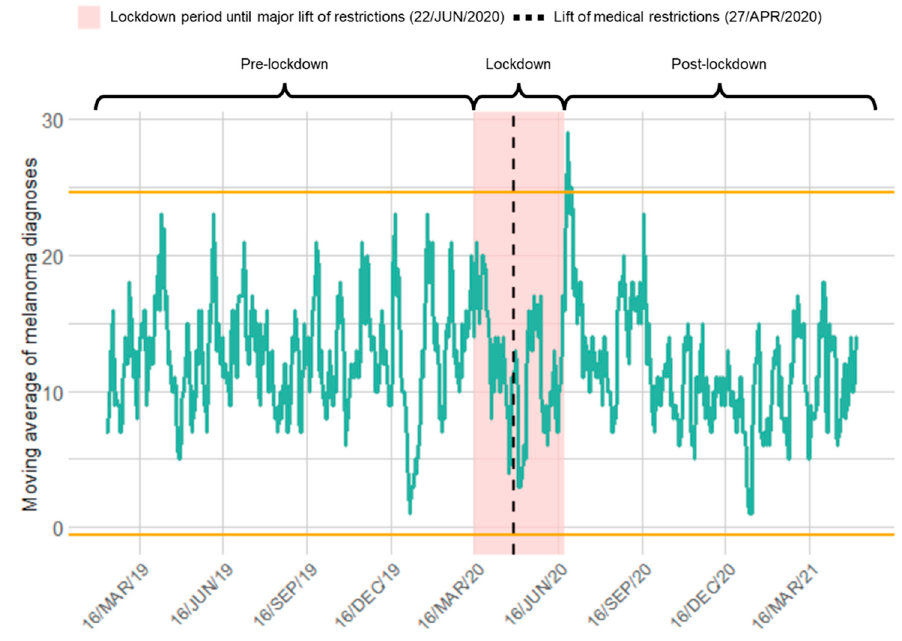
Figure 1. Time series of newly diagnosed melanomas relative to COVID-19 lockdown in Switzerland: A significantly higher rate of diagnosed melanomas was observed after the lift of major restrictions. The green line shows the rate, i.e., the moving 7-day average of diagnosed melanomas, considering a period of two years and three months centered on the official lockdown onset (16/MAR/20). The yellow lines represent three standard deviations above and below the mean of the considered interval. The shaded red area represents the lockdown period in Switzerland, defined here as the period between the official lockdown onset and the date for the major lift of restrictions (22/JUN/20). The black dashed line represents the date of the lift of medical restrictions (27/APR/20).